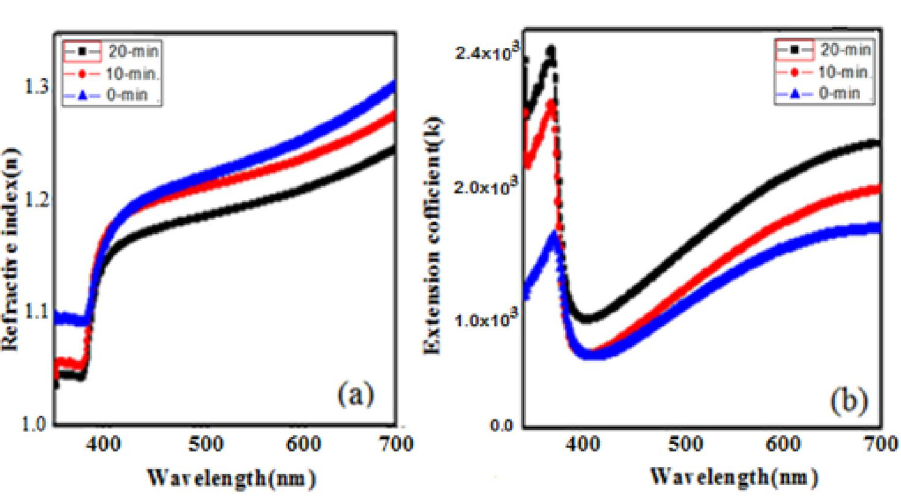
Figure 5. ( a ) Refractive index and ( b ) Extinction coefficient of as-grown and irradiated ZnO-CdO coated